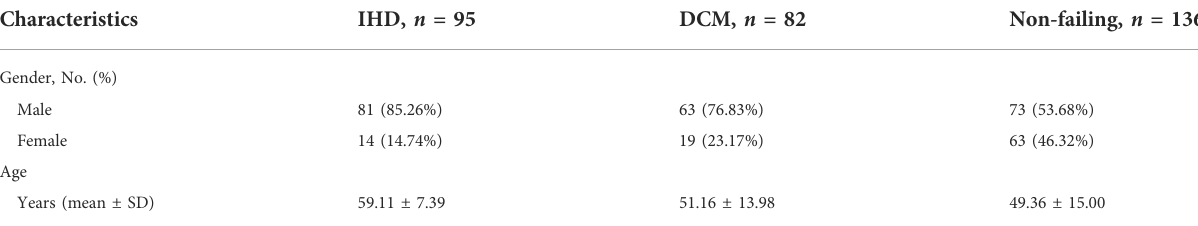
TABLE 3 Characteristics of patients.